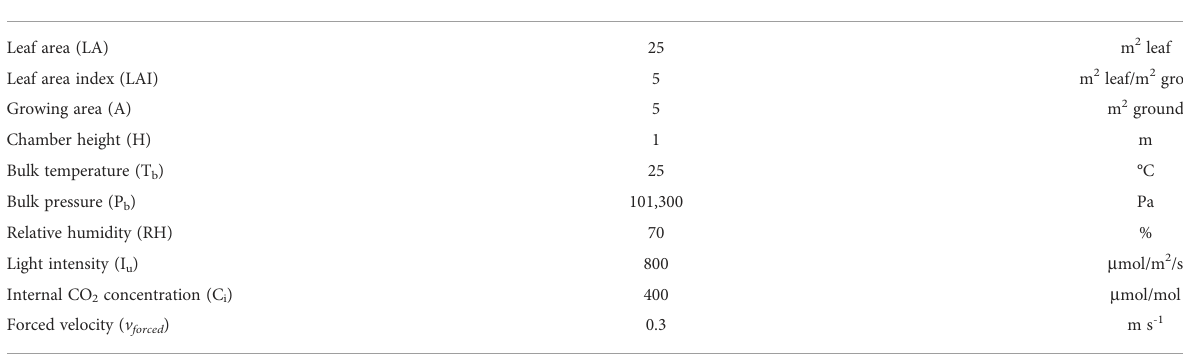
TABLE 4 List of operating parameters used in FBA